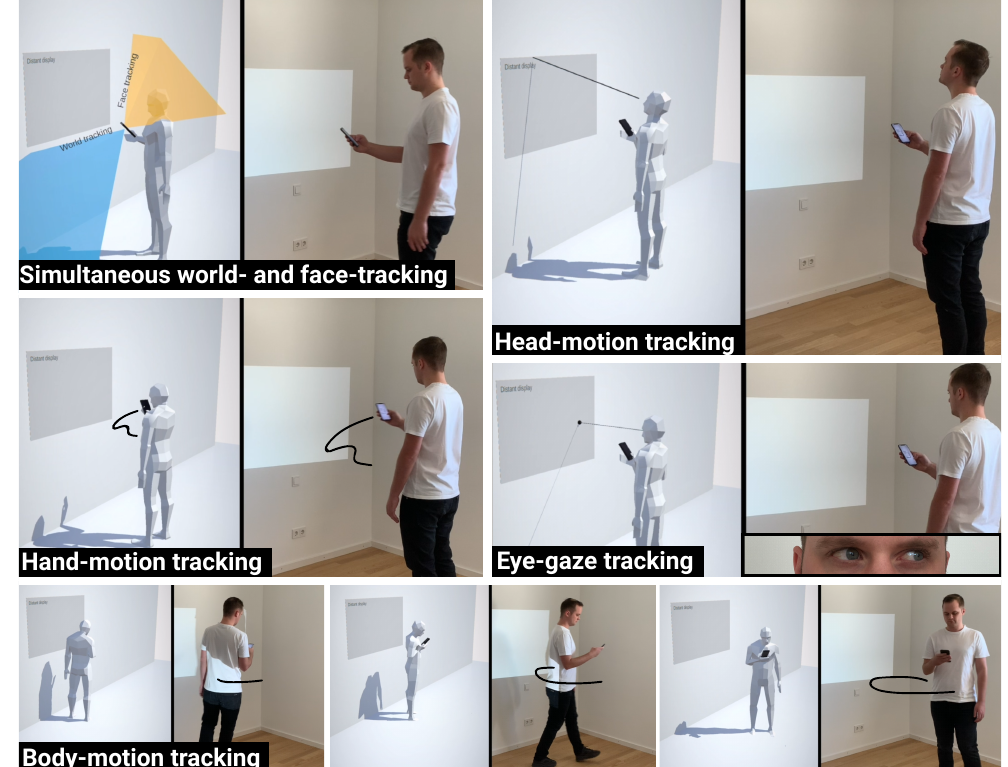
Figure 1. TrackPhone uses simultaneously the front and rear camera of the smartphone for tracking of the absolute world-space pose of the user’s device (hand), body, head, and eyes (gaze). Combined with touch inputs, this enables, after a simple app download, any smartphone user to perform powerful multi-modal spatial interactions for distant